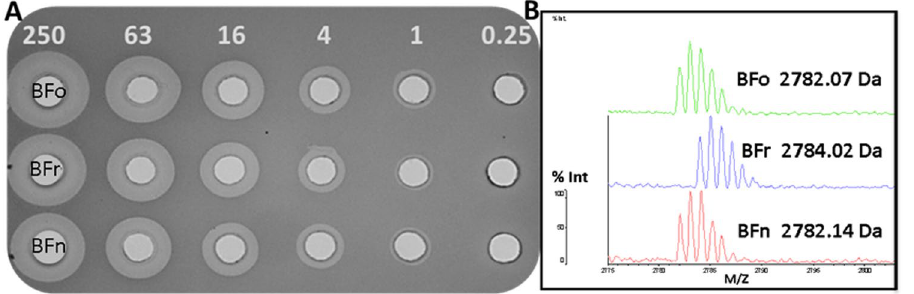
Figure 1. Activity ( µ M) of oxidized synthetic bactofencin A (BFo), reduced bactofencin A (BFr) and natural bactofencin A (BFn) against S . aureus DPC5246 ( A ) and molecular mass of oxidized synthetic bactofencin A (Top), reduced bactofencin A (Middle) and natural bactofencin A (Bottom) ( B